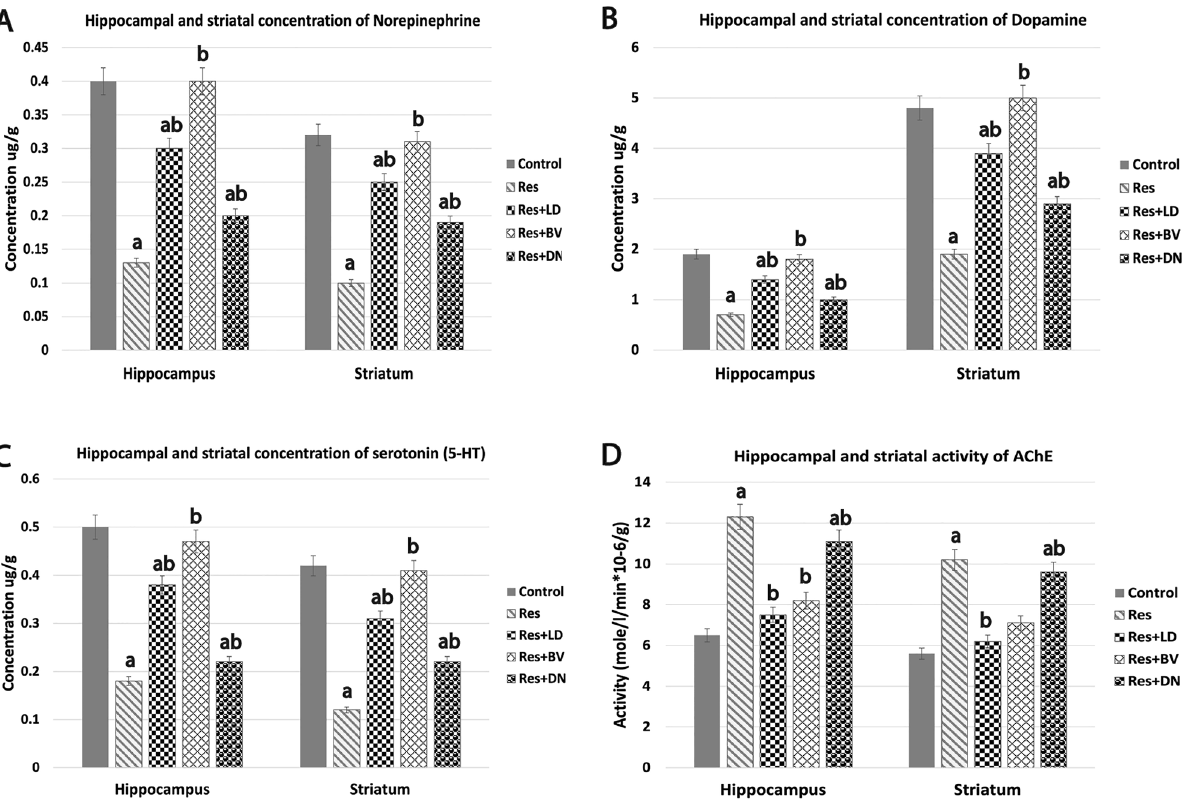
Figure 2. HPLC analysis of the effects of L-Dopa, BV, and DA nanoparticles on hippocampus and striatal monoamines, as well as AChE activity, in a reserpine-induced Parkinson’s rat model. ( A ) Norepinephrine, ( B ) Dopamine, ( C ) Serotonin (5-HT), and ( D ) AChE. Data are expressed as Mean ± S.E. for 6-rats/group. a indicates significant difference from control group ( p < 0.05), b indicates significant difference from the reserpine-treated group, ab indicates significant difference from both control and reserpine-treated group.